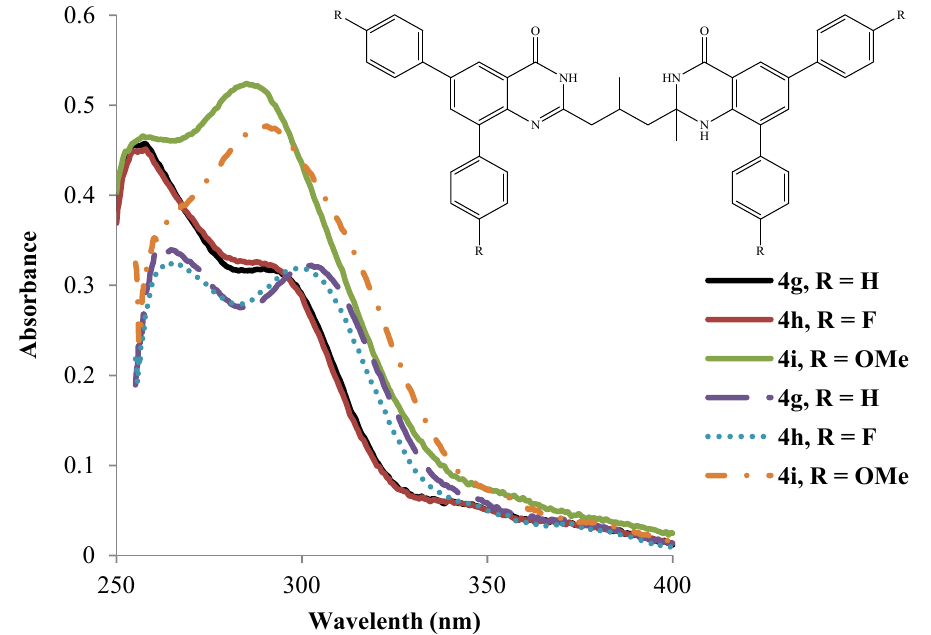
Figure 4. UV-Vis spectra of 4g – i in DMSO (dashed lines) and CH rt (conc. = 1.0 × 10 − 5